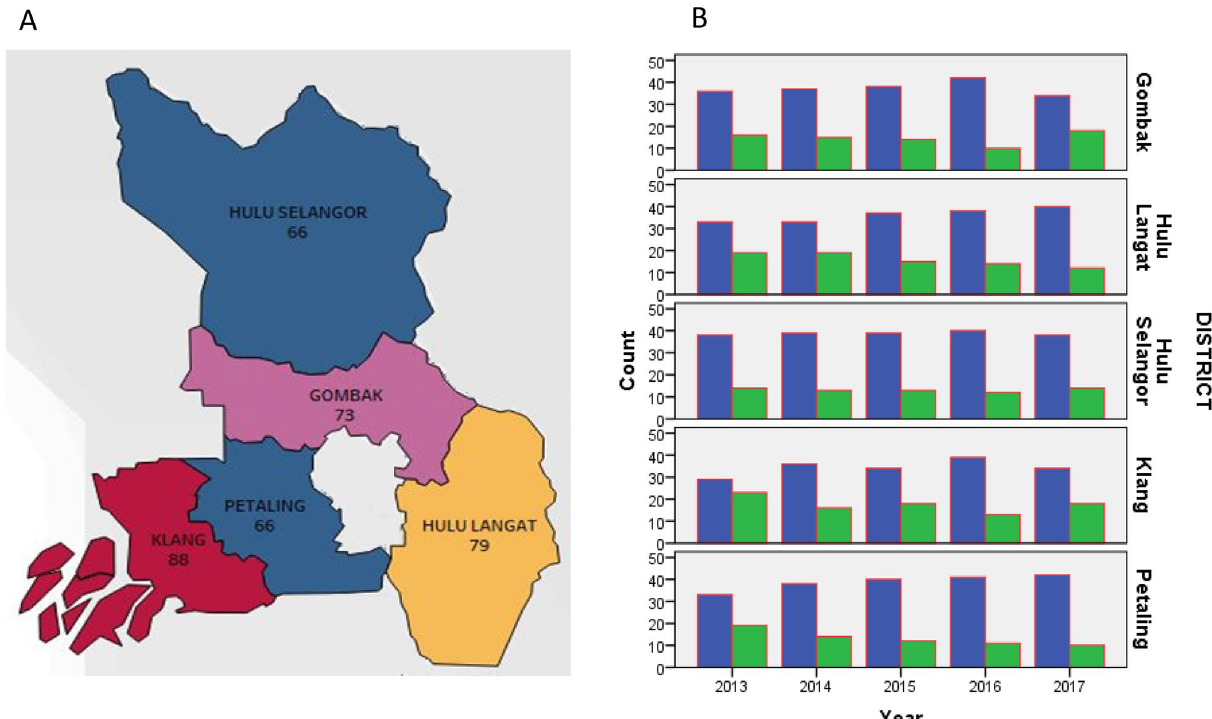
Figure 1. ( A ) Dengue fever outbreak in Selangor (study areas). ArcGIS 10.7 was used to create the map (https ://deskt op.arcgi s.com/en/), ( B ) Dengue fever outbreaks by district and year (blue is representing no and green is representing